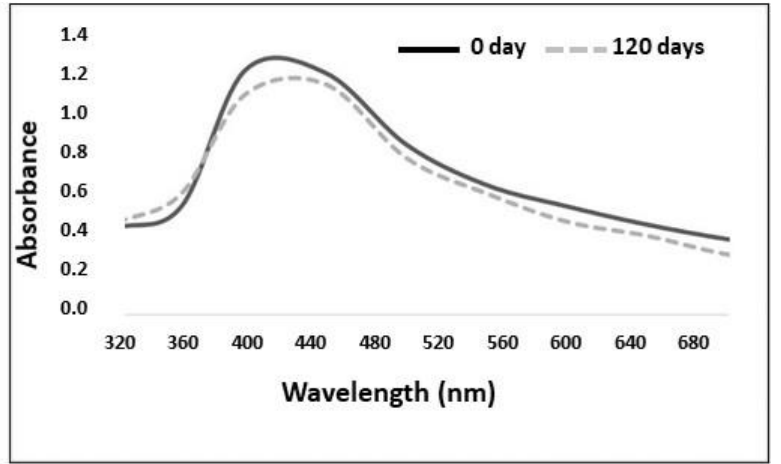
Figure 1. Change in the color of the solution after reduction of the silver complex, showing the formation of nanoparticles stabilized with the biosurfactant (BS-AgNPs).